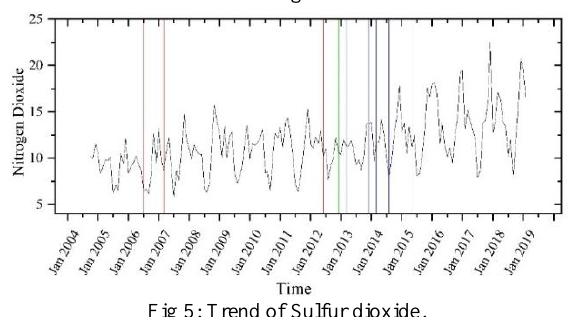
Fig 5: Trend of Sulfur dioxide.